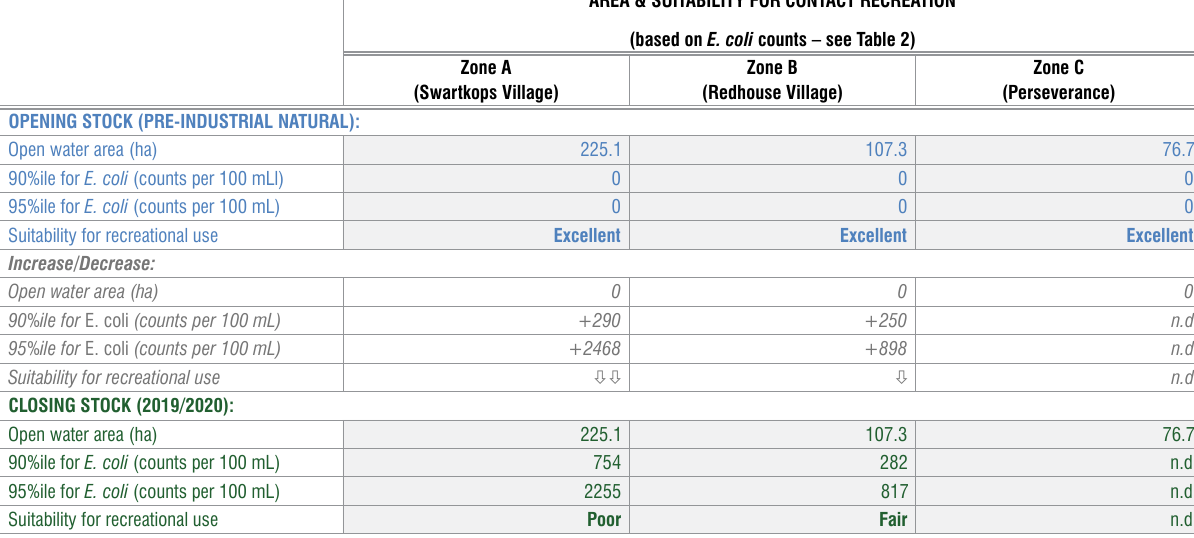
Ecosystems services account for recreational use in Swartkops Estuary